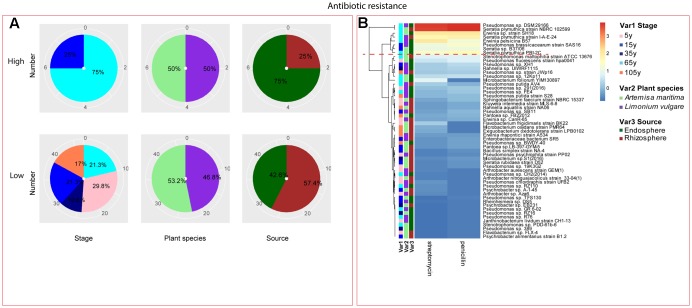
Distribution of antibiotic resistance of root-associated bacterial strains. (A) Distribution of isolates from different treatments according to high and low activities in antibiotic resistance. (B) Heatmap profiles for antibiotic resistance of all isolates. The annotation of treatments – successional stages, plant species and plant compartments and corresponding colors are the same with those in Figure 4. The blue-red gradient bar represents the normalized absorbance values (Z-scores). Only the integer scaled values (0–3) were shown alongside the color bar. The red dashed line separates the high and low bacterial functional profiles, which were determined by the cluster assignment based on the average Euclidean distance among the bacterial strains.